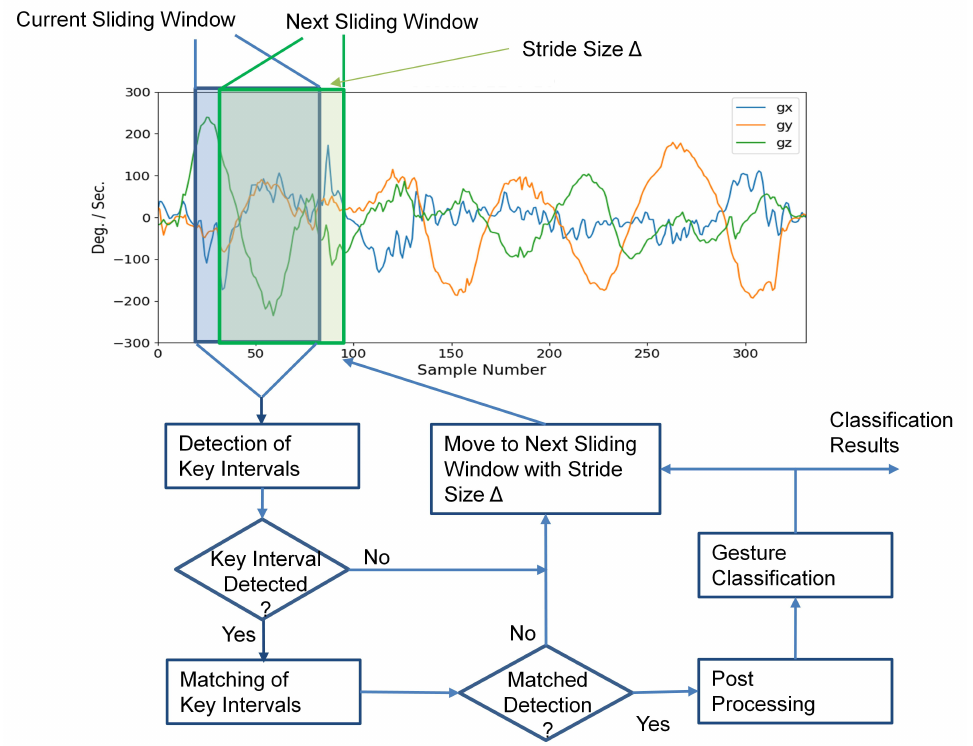
Figure 4. The inference operations of the proposed neural network for an input sequence. There are three major operations for each sliding window of the input sequence: detection of key intervals, key interval matching, and postprocessing. The same operations are repeated for each sliding window with stride size ∆ until the final window of the input sequence is